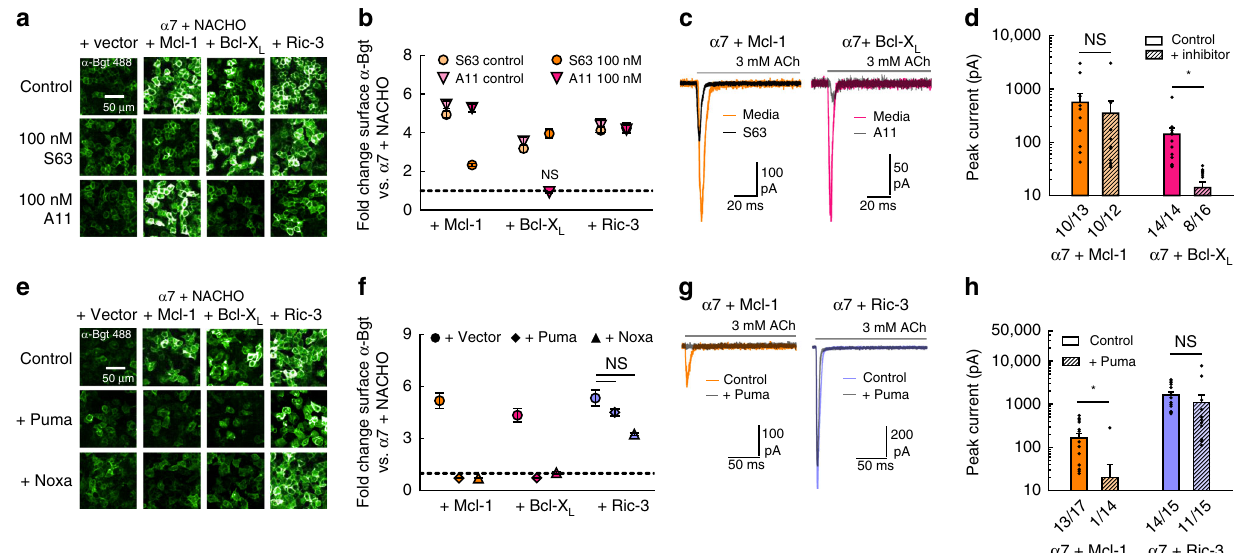
Fig. 2 Chemical inhibitors and BH3-only proteins eliminate Bcl-2-mediated upregulation of α 7 nAChRs. a Fluorescent α -Bgt labeling of nonpermeabilized HEK293T cells cotransfected with cDNAs encoding α 7 and NACHO, along with other proteins indicated, at a 1:3:4 respective ratio. b Surface α -Bgt labeling with S63 or A11 inhibitors, presented as a fold change in fl uorescence intensity ( n = 5 treated, n = 10 control), relative to α 7 and NACHO expressed alone. Enhancement of fl uorescence remained signi fi cant in all cases ( p < 0.01) except cells expressing Bcl-X L treated with 100 nM